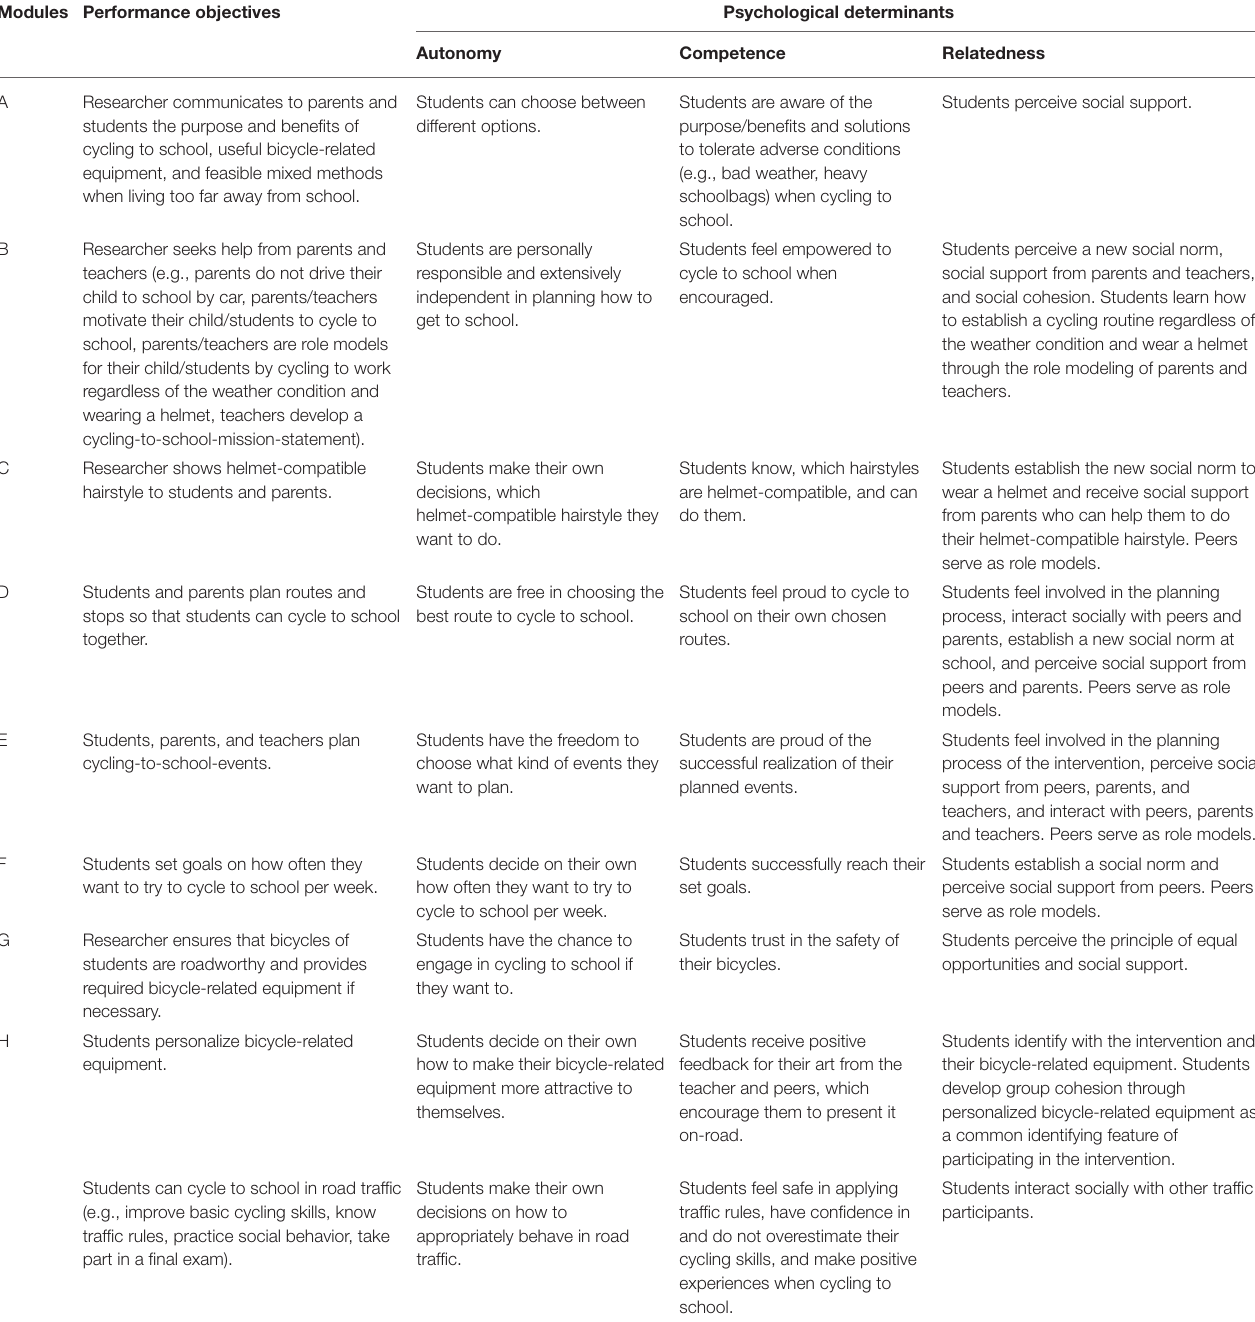
TABLE 1 | Matrix of performance objectives and determinants targeting the promotion of cycling to school. Modules Performance